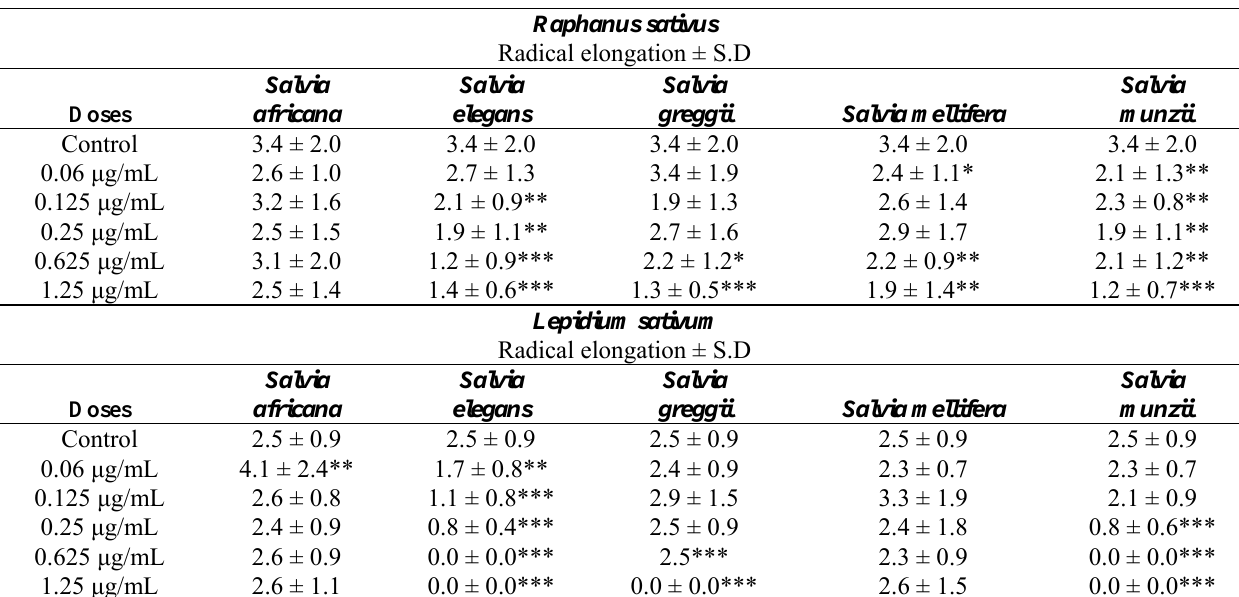
Table 3. Biological activity of essential oils of Salvia africana , Salvia elegans , Salvia greggii , Salvia mellifera and Salvia munzii against radical elongation of Raphanus sativus and Lepidium sativum , 120 h after sowing. Data are expressed in cm. Results are the mean of three experiments ±